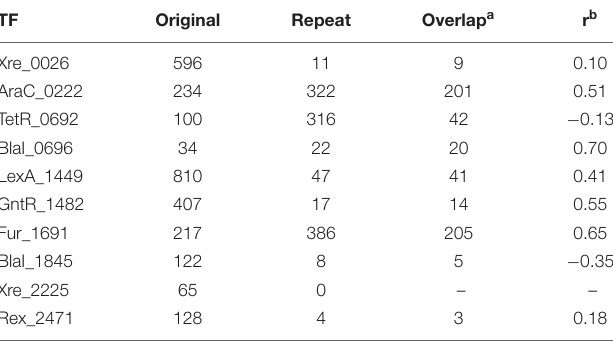
TABLE 2 | Peak counts and correlation of peak fold changes between the original, large-scale screen and a targeted DAP-seq repeat experiment of a few selected